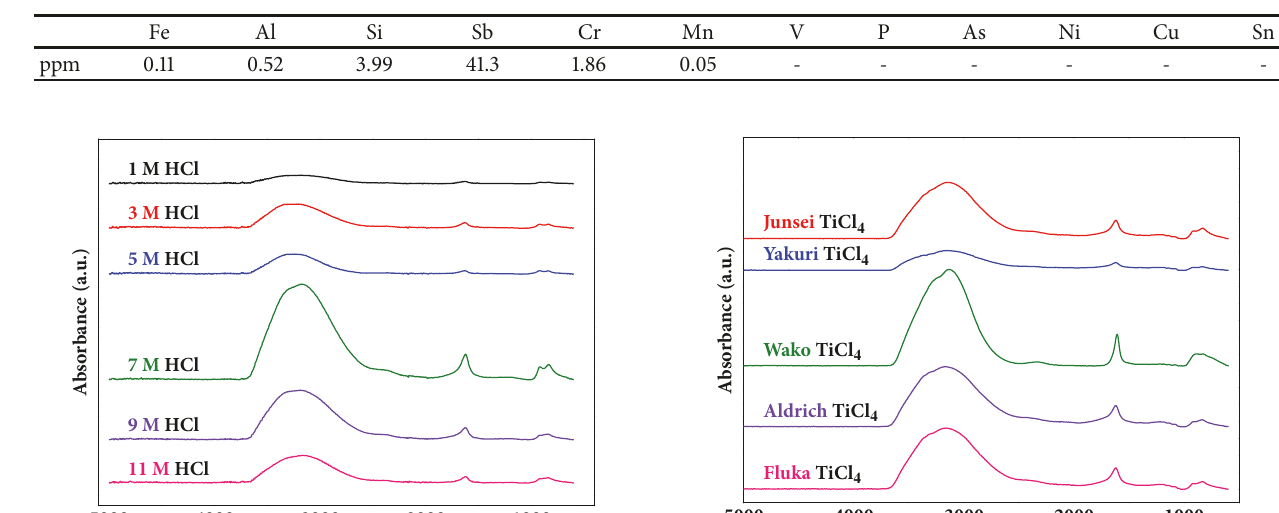
Table 2: Quantitative determination of impurities in titanium tetrachloride via ICP-OES.